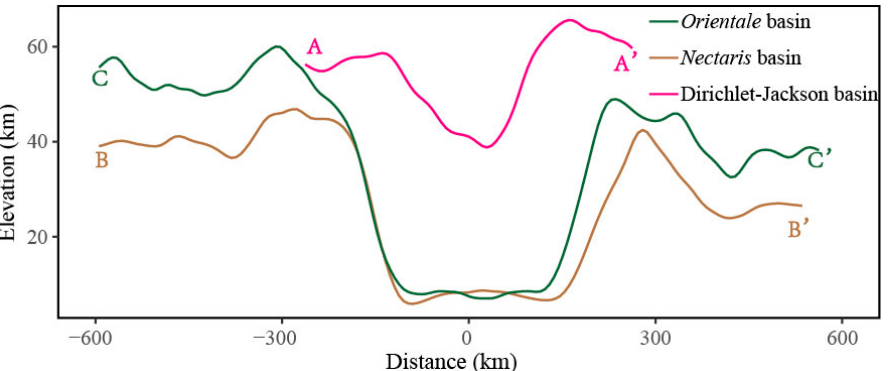
Figure 16. Crustal thickness comparison map of the three basins, wherein 0 on the x -axis corresponds to the center of the three basins, negative values on the x -axis represent the direction from the center of the basin to the start of the topographic profile, and positive values on the x -axis represent the direction from the center of the basin to the end of the topographic profile.